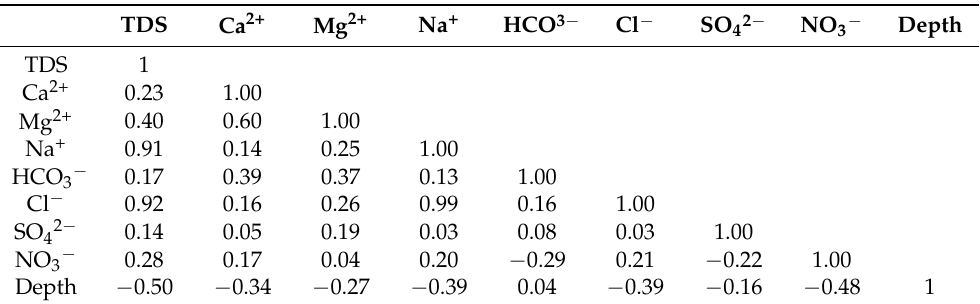
Table 2. Correlation matrix of the different parameters analyzed for the samples of groundwater from drinking water wells in the West